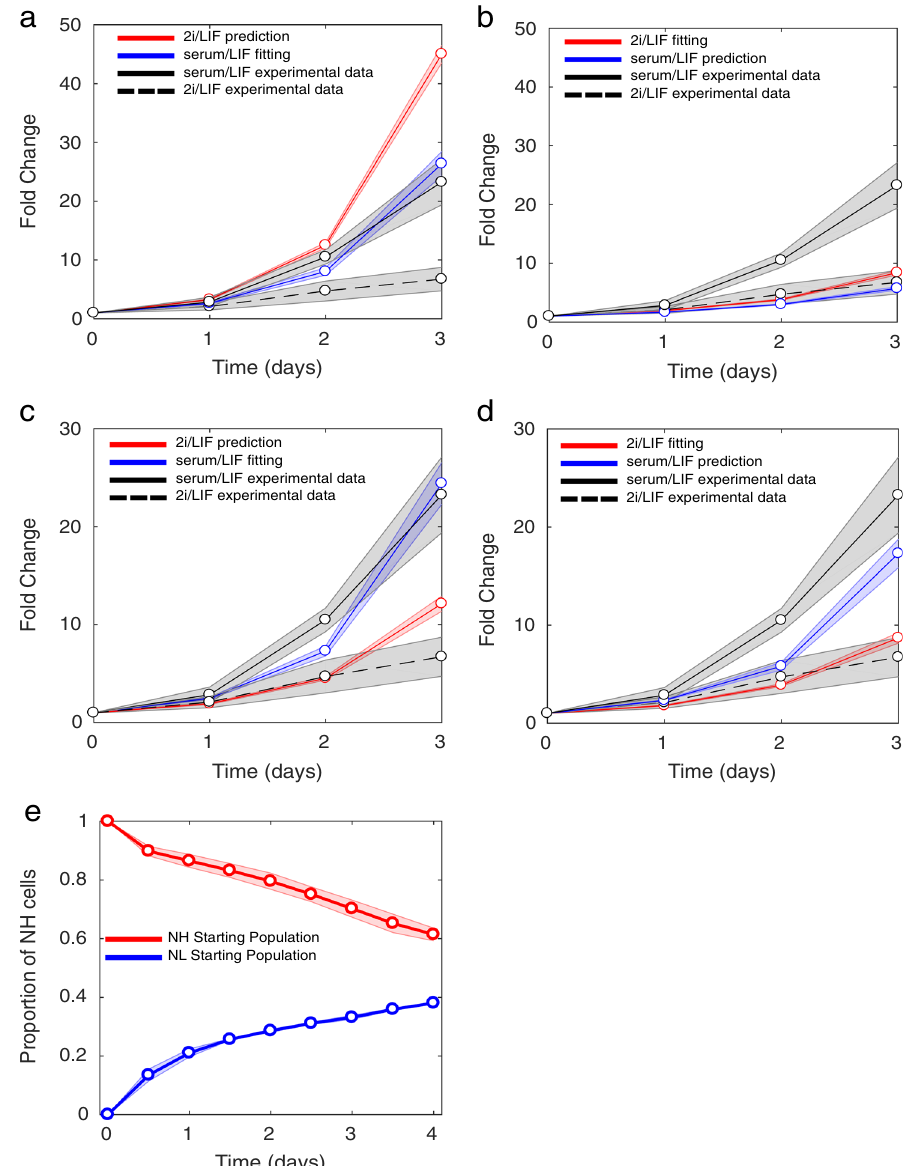
Fig. 6 Agent-based modelling results for Nanog-dependent or Mycn-dependent cell-cycle ( a , b ) Nanog-dependent cell-cycle model simulations. a The blue line depicts the Nanog-dependent cell-cycle model fi tted to serum/LIF proliferation data (data shown as solid black line , RMSE 2.35), while the red line is the predicted cell-growth in 2i/LIF (RMSE 22.59 as compared to 2i/LIF data, shown as dashed black line ). Each cell cycle was independently sampled from a normal distribution with mean 8.5 h for NH and 13.5 h for NL, and standard deviation 1 h for both NH and NL. b The red line shows fi tting of the Nanog-dependent cell-cycle model to 2i/LIF data (RMSE 1.07), with prediction of growth in serum/LIF plotted in blue (RMSE 11.01); cell cycles were allocated with mean 13.175 h for NH and 20.925 h for NL. c , d Mycn-dependent cell- cycle model simulations. c The blue line depicts the Mycn-dependent cell-cycle model fi tted to serum/LIF data ( solid black line , RMSE 2.02), while the red line is the predicted cell growth in 2i/LIF (data shown as dashed black line , RMSE 3.08). In this case the cell cycles were allocated from a normal distribution with mean 8.5 h for Mycn High (MH) and 15 h for Mycn Low (ML). d The red line shows the Mycn-dependent cell- cycle model fi tted to 2i/LIF data (RMSE 1.33) with serum/LIF predicted growth dynamics plotted in blue (RMSE 4.41). The cell cycles were allocated with means 9.5 h for MH and 16 h for ML. ( e ) Agent-based simulations of Nanog sorting experiment (Mycn-dependent cell-cycle model) in serum/LIF. The red and blue lines depict the changing ratio of NH cells in the population starting from NH or NL state, respectively. In a – d , data are the average of four independent experiments. Cell count, performed every 24 h for 3 days, is plotted as fold change vs. count at day 0; Standard Error (SE) is shown as a shaded grey region . In a – e , all model simulations are the average of 15 independent simulations, with the shaded regions showing altered to match experimental data (Supplementary Information). These results con fi rm that Nanog auto-activation is suf fi cient to Results of continuation of the Nanog steady-state against its auto- explain bistability of the system. As in our NIA bank analysis, two independent studies have regulatory rate are comparable to those obtained with the full recently reported that Nanog might function as an auto-inhibitor network under the same parameters for inputs and noise (compare of itself rather than an activator. 54, 55 We investigated if we could Fig. 5b, c with Figs. 2c and 3c for serum/LIF and 2i/LIF, respectively).